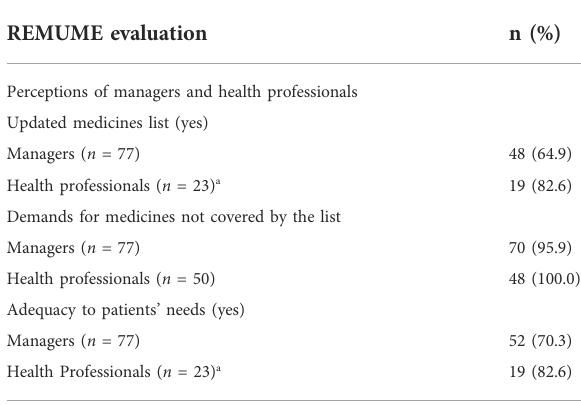
TABLE 3 Managers and health professionals ’ perceptions regarding the Municipal Lists of Essential Medicines (REMUME). MedMinas Project, 2019.